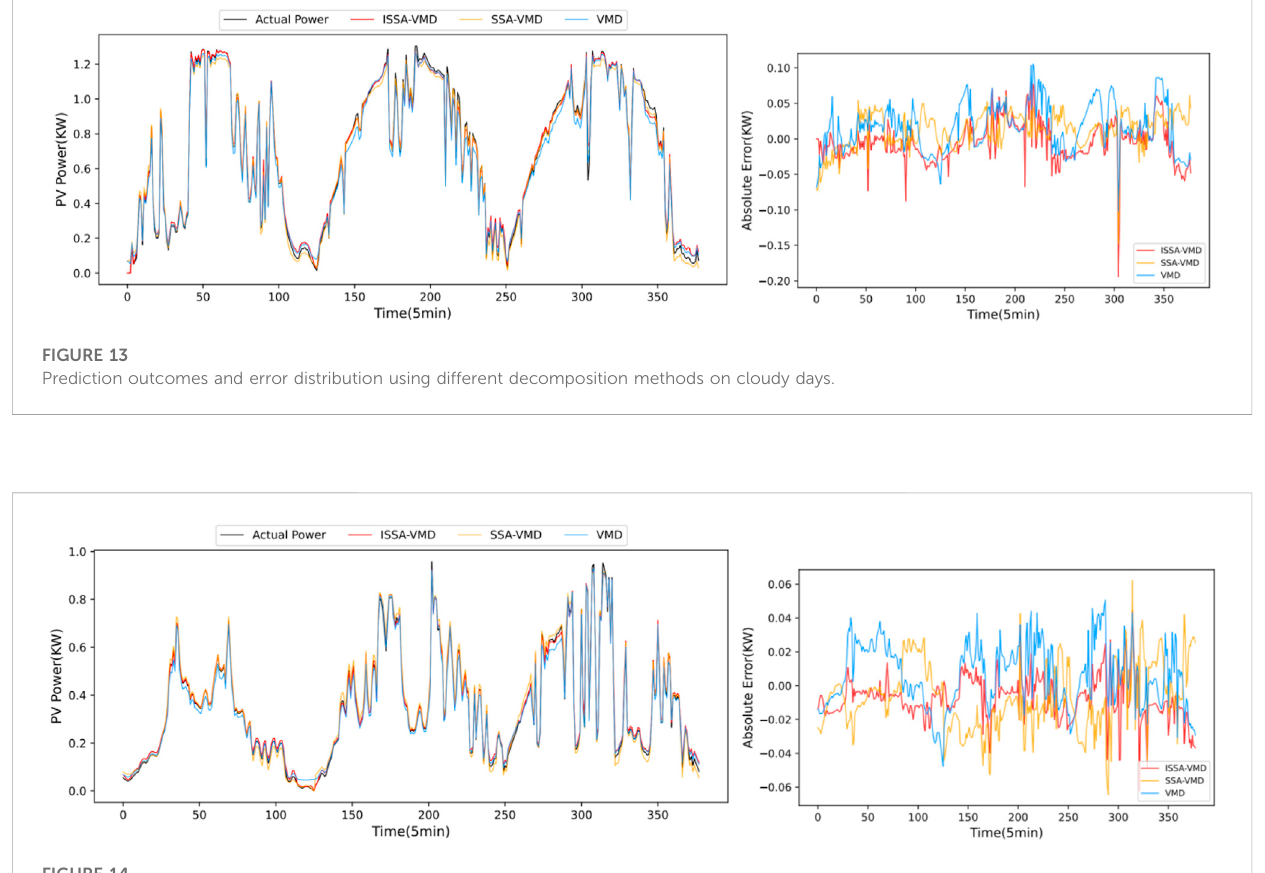
FIGURE 14 Prediction outcomes and error distribution using different decomposition methods on rainy